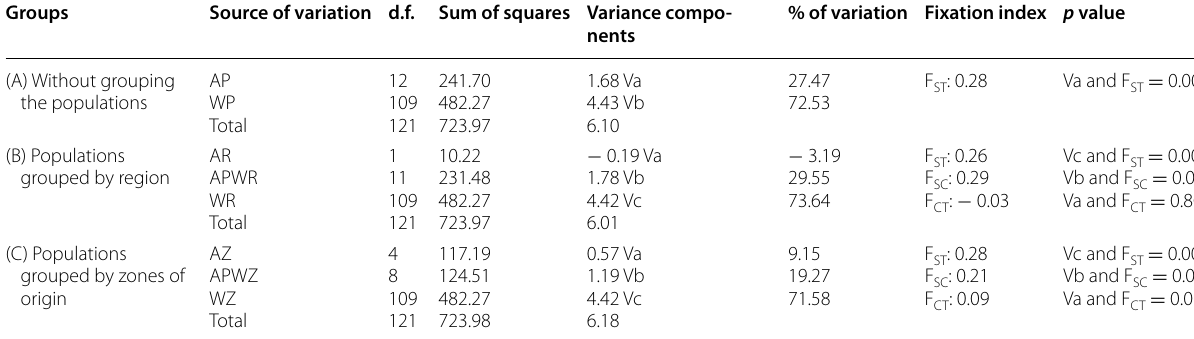
Table 6 Analysis of molecular variance (AMOVA) of A. corrorima populations based on seven ISSR primers